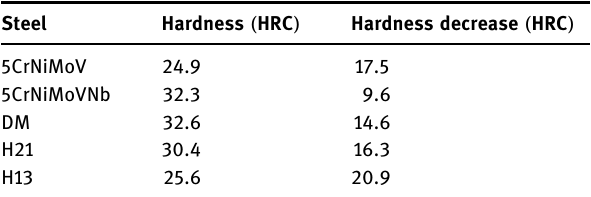
Table 4: The hardness value of several hot - work die steels tem - pered at 650°C for 24